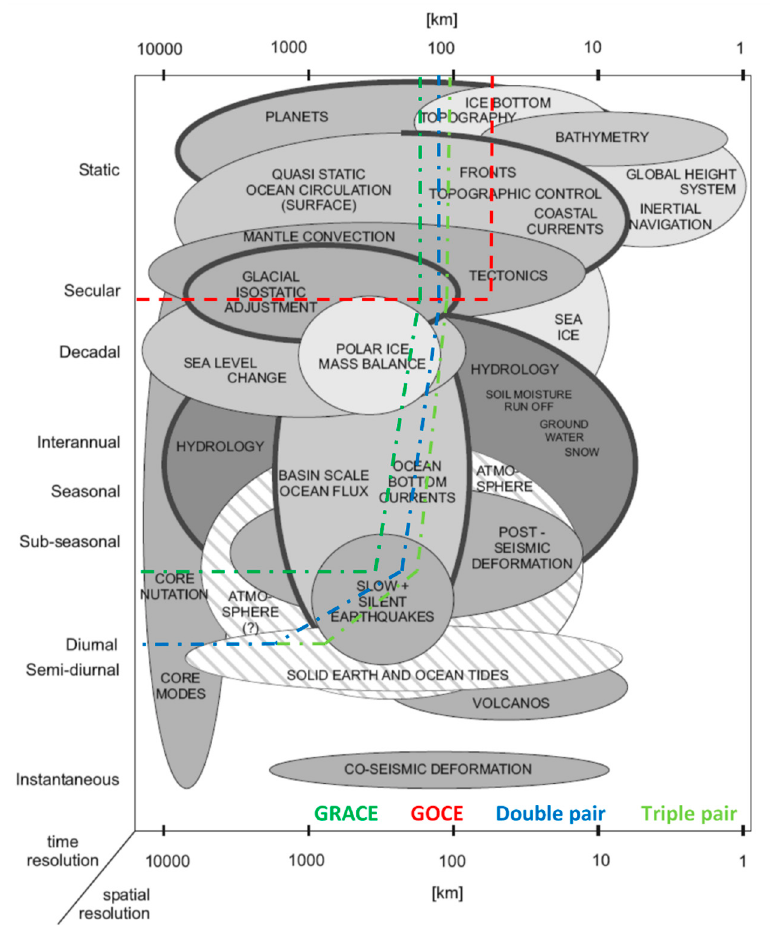
Figure 2. Temporal and spatial scales of time-varying gravity field as well as the spatial and temporal limits of Gravity Recovery and Climate Experiment (GRACE), Gravity field and steady-state ocean circulation explorer (GOCE), and possible next-generation gravity missions (NGGM) constellations. Based on [31] .